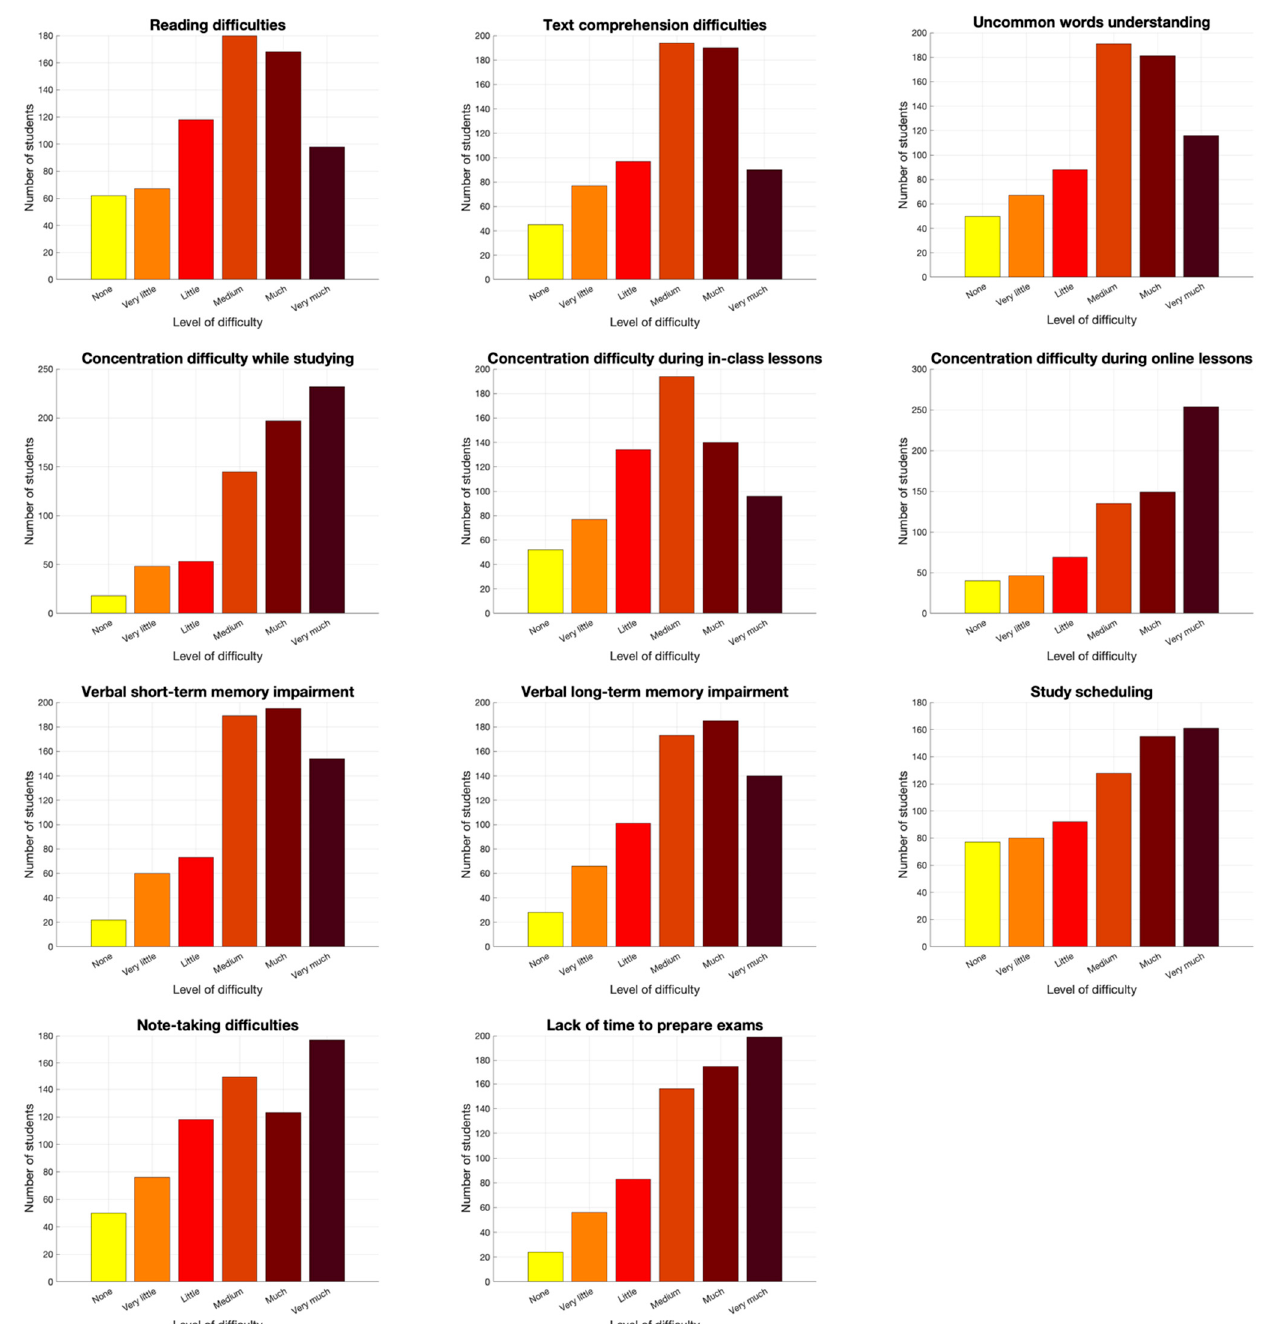
Figure A1. Histograms of the scores given by dyslexic students to the importance of each issue present in the question- naire.